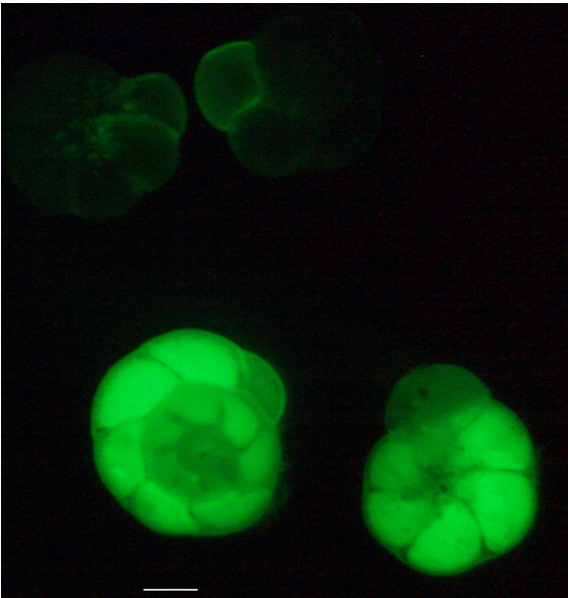
Figure 2. Example of calcein-labelled specimens of Ammonia tep- ida as they were observed before incubation in FDA (top), and two living specimens after FDA incubation (bottom). Photo exposure time: 1 / 4 00 . Scale bar is